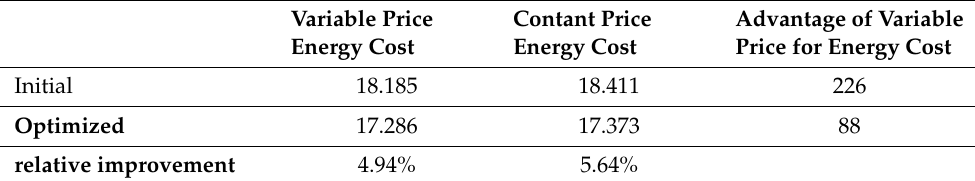
Table 3. Influence of variable and constant energy prices (in €